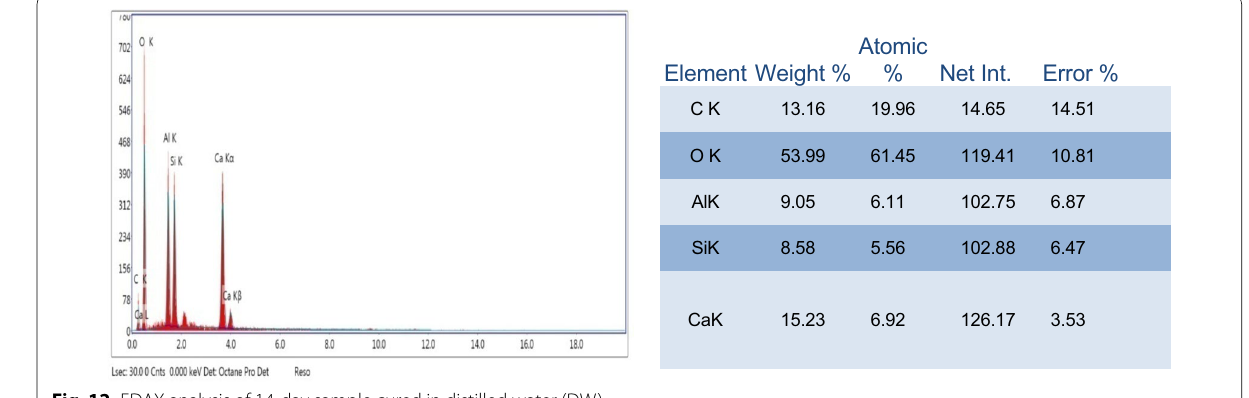
Fig. 12 EDAX analysis of 14-day sample cured in distilled water